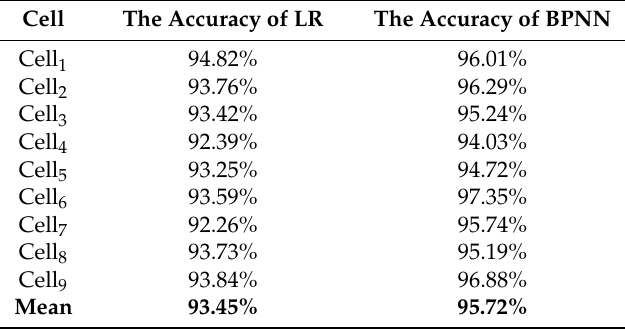
Table 9. The accuracies of vehicle speed forecasting of each road